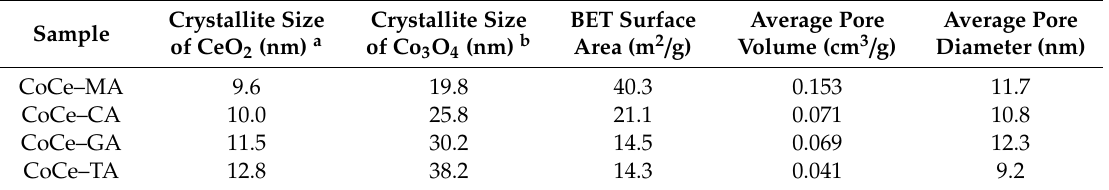
Table 2. Crystallite sizes and structural parameters of the CoCe–X